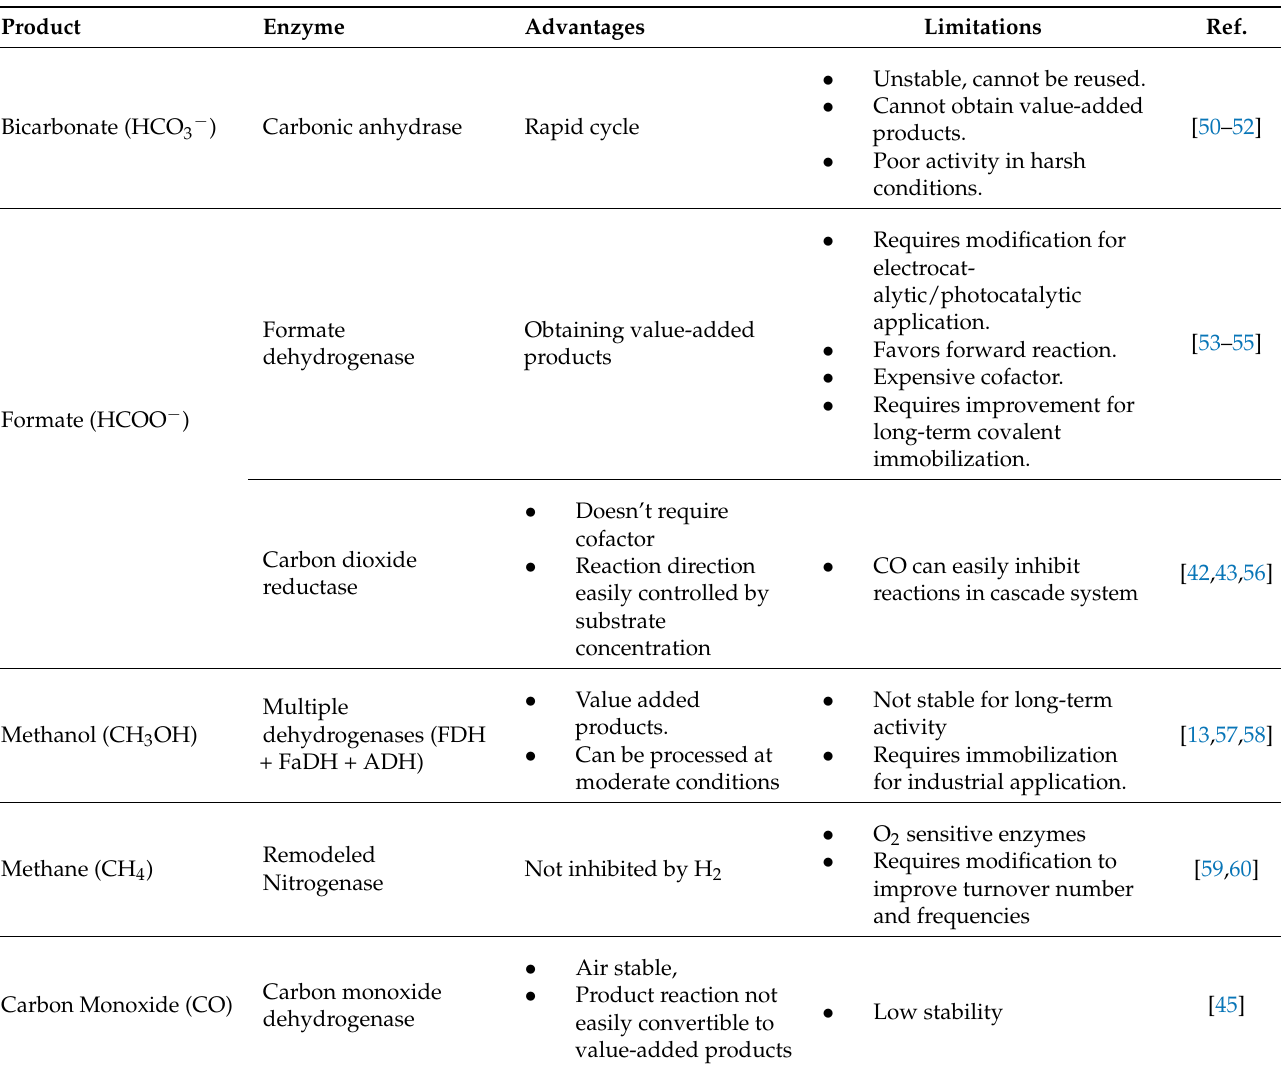
Table 1. Enzymes used for production of various products via in vitro CO 2 conversion (modified from